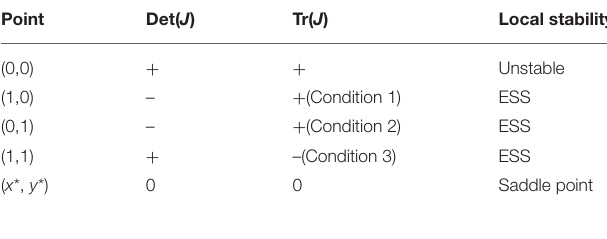
TABLE 3 | Local stability of five points.